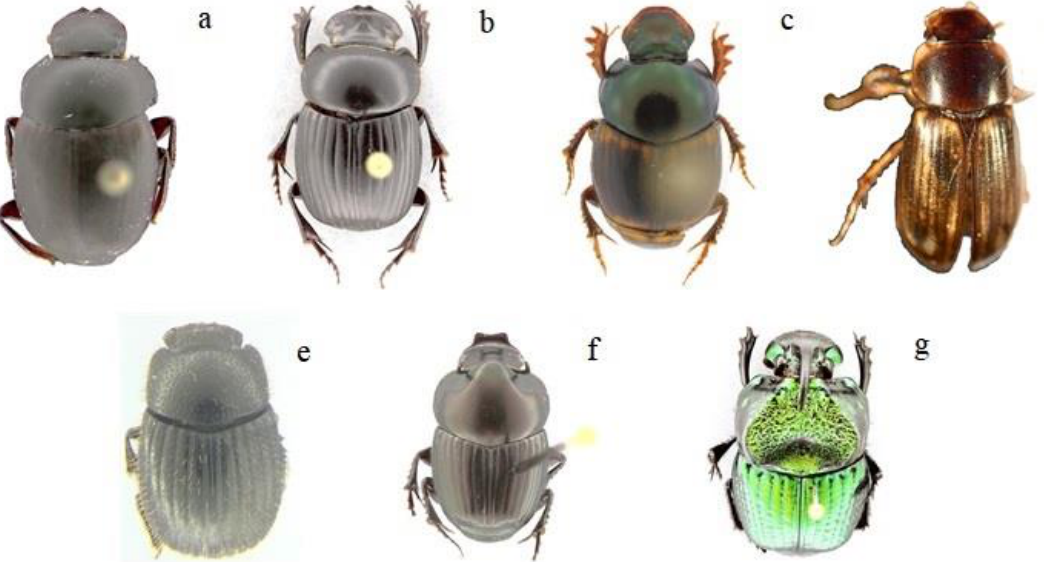
Figure 3. Dung beetle species found in different L-UCH classes in a disturbed tropical dry forest (TDF) ecosystem in southern Ecuador. ( a ). Canthon balteatus ; ( b ). Dichotomius problematicus ; ( c ). Onthophagus confusus ; ( d ). Aphodius sp1; ( e ). Onoreidium ohausi ; ( f ). Onthophagus curvicornis ; ( g ). Phanaeus achilles .